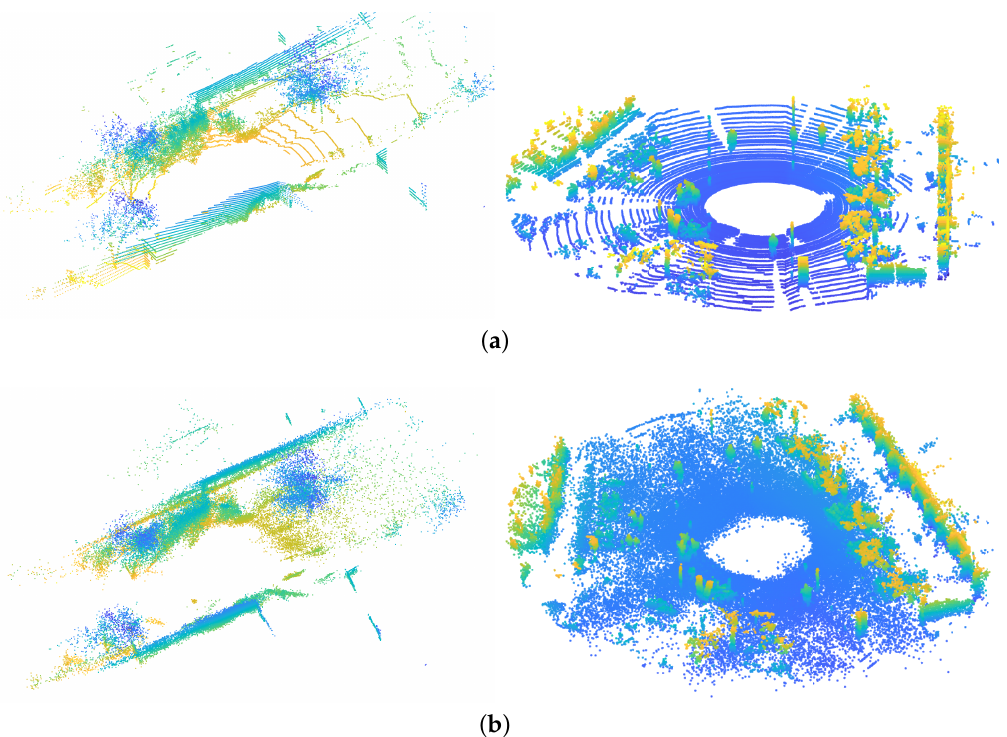
Figure 6. The raw point clouds of the Lidar datasets and the reconstructed point clouds by our approach. ( a ) Raw point cloud; ( b ) Reconstruction using our approach.